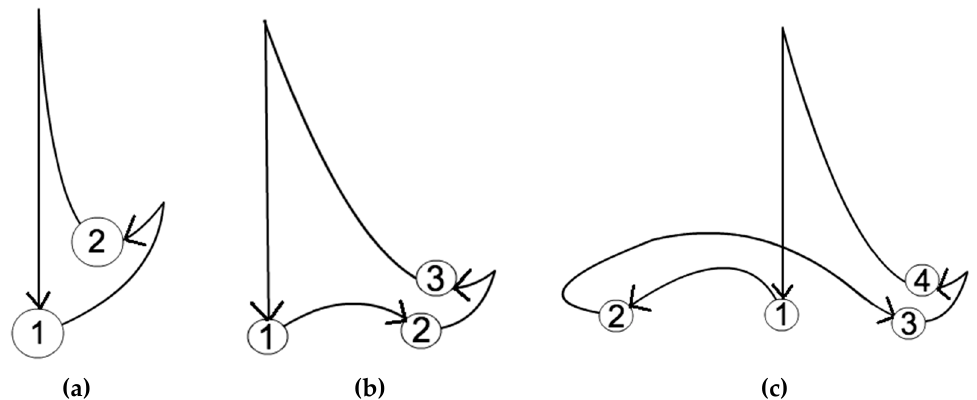
Figure 1. Three basic hand gestures of a musical conductor: ( a ) 2/4 duple, ( b ) 3/4 triple, and ( c ) 4/4 quad.